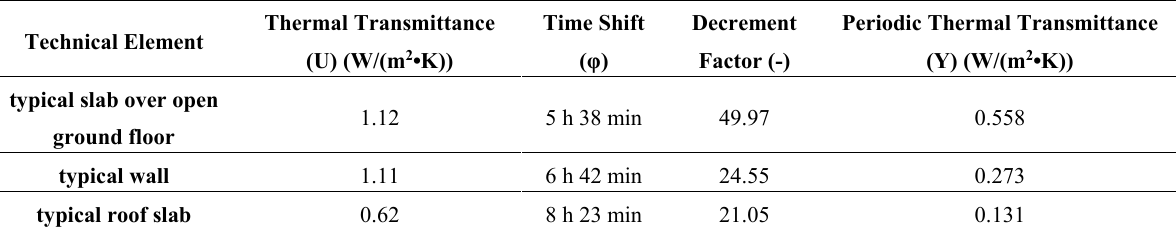
Table 2. Thermal characteristics of main elements.